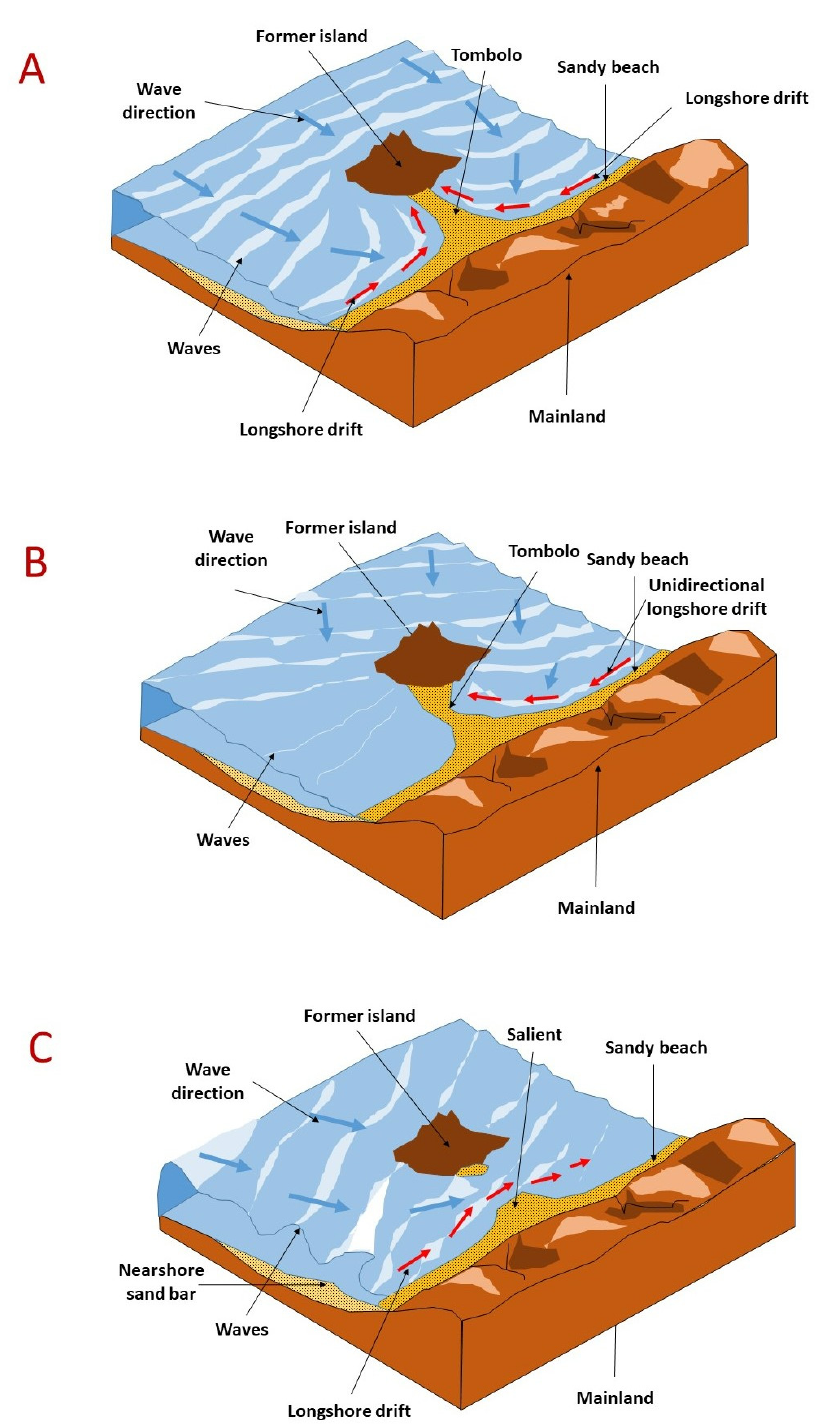
Figure 20. Description of ( A ) the general case of tombolo formation by longshore drift from the two sides of the tombolo, ( B ) another case of tombolo formation by a unidirectional longshore drift, and ( C ) the case of salient formation by extreme wave conditions.